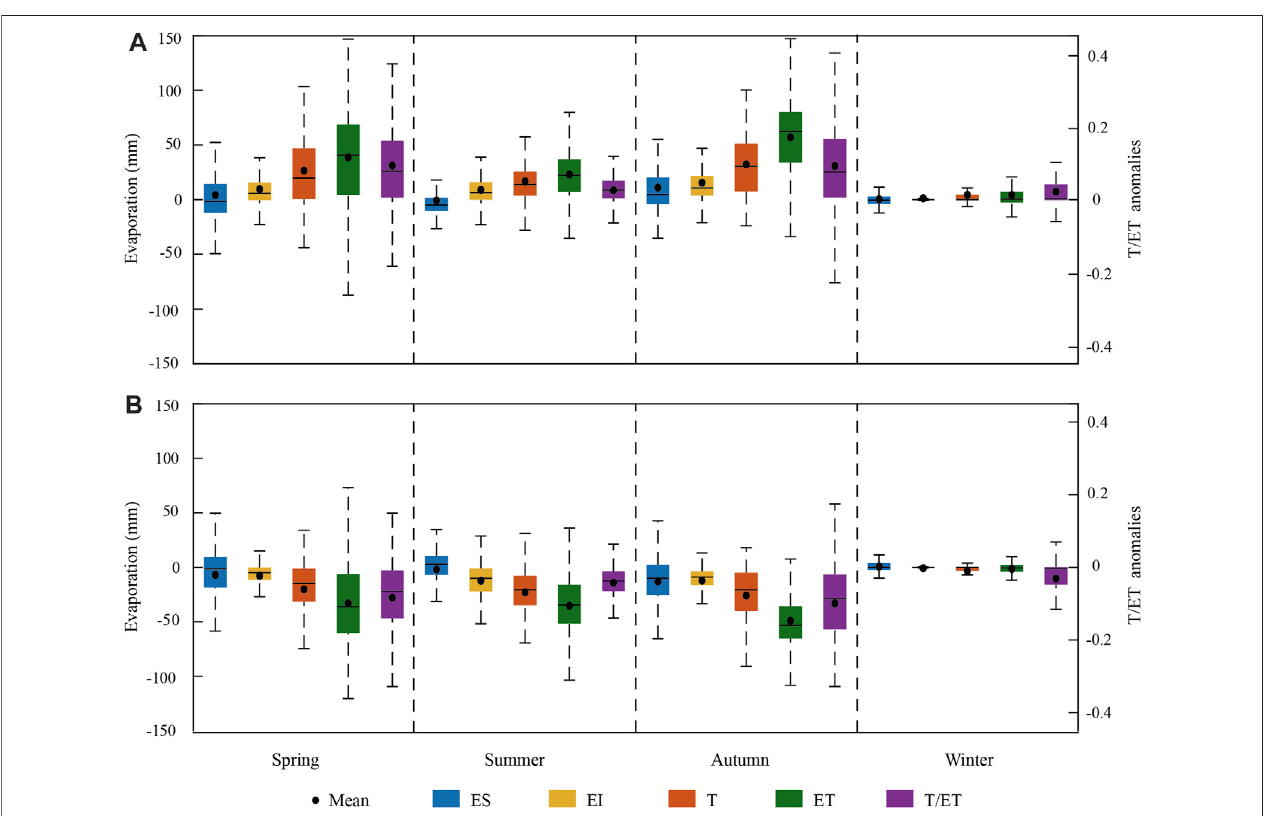
FIGURE 9 | The seasonal anomalies of ET, T/ET, and different components of ET in China during 1982 – 2015. Positive anomalies (A) and negative anomalies (B) .